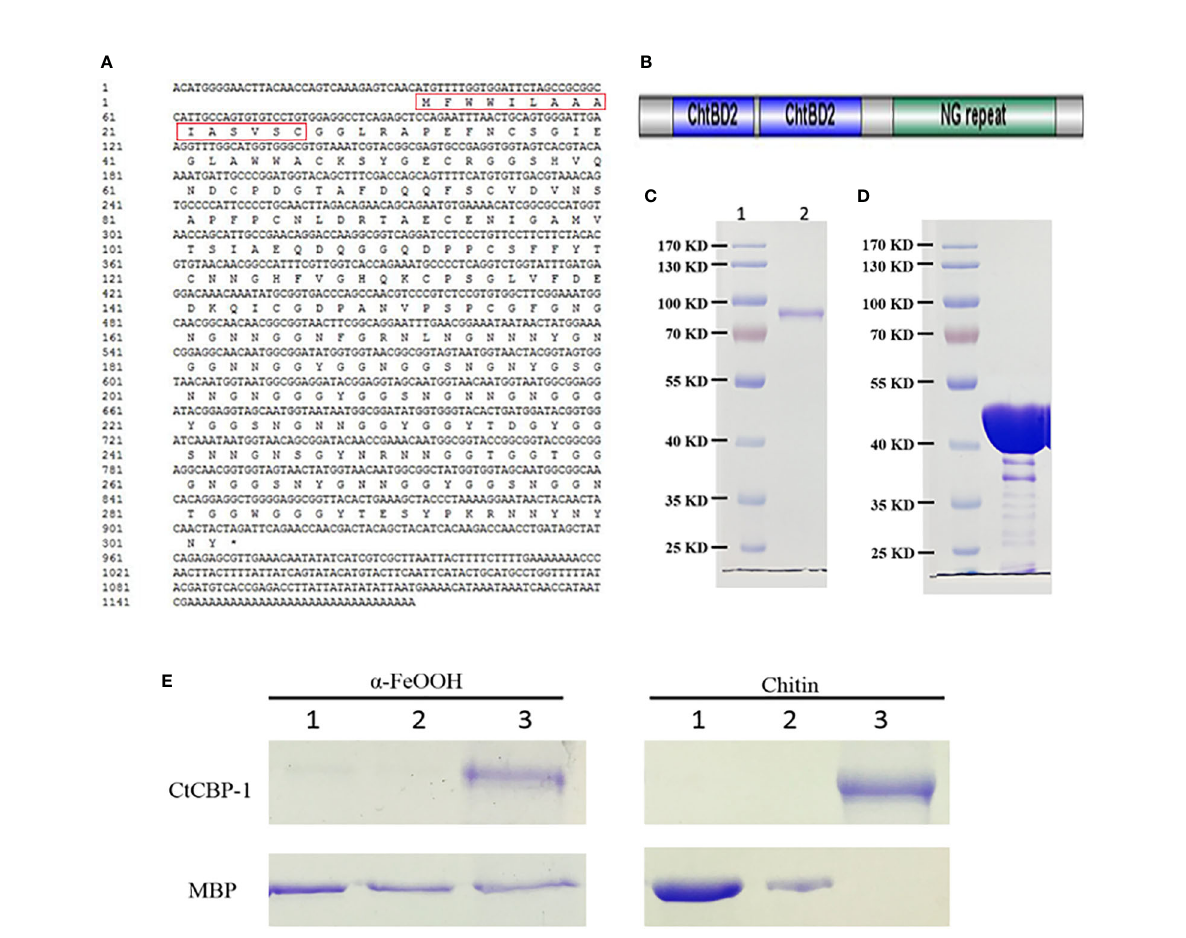
FIGURE 1 (A) The cDNA sequence information of CtCBP-1. Red box is the signal peptide. (B) Schematic diagram of the structural domain of CtCBP-1 without signal peptide. (C) SDS-PAGE of recombinant protein CtCBP-1 with MBP tag near 80 kD. (D) SDS-PAGE of recombinant protein MBP tag at 40 kD. (E) Binding properties of CtCBP-1 with goethite and chitin. Lane 1, residual unbound CtCBP-1 and MBP in deionized water wash fraction after incubation with a -FeOOH or chitin; Lane 2, residual unbound CtCBP-1 and MBP in 0.5 M NaCl wash fraction after incubation with a -FeOOH or chitin; Lane 3, the eluate after boiling SDS denaturant containing b -mercaptoethanol for 10